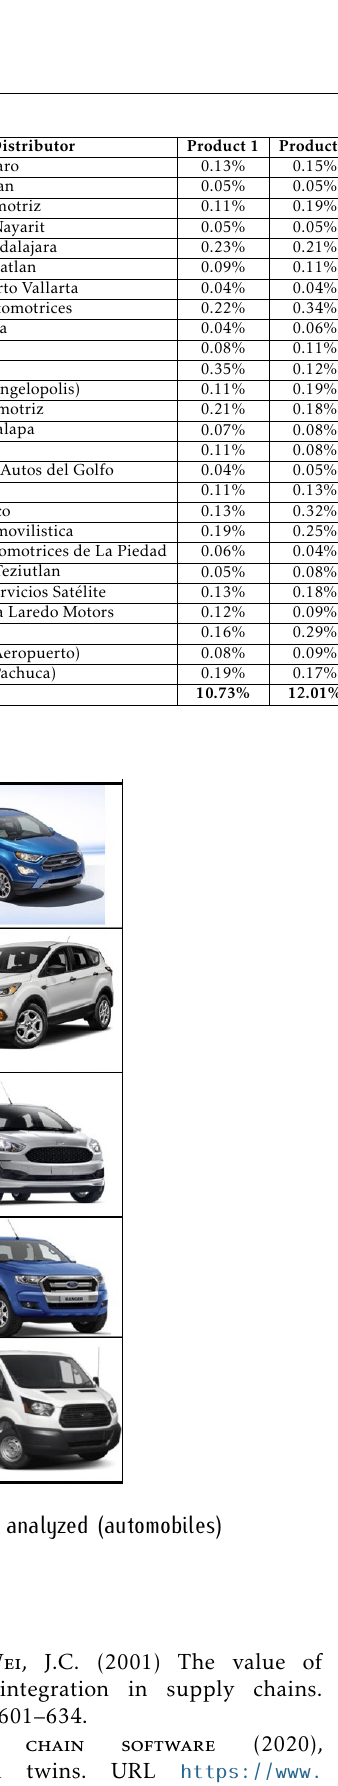
anylogistix.com/resources/white-papers/ supply-chain-digital-twins/